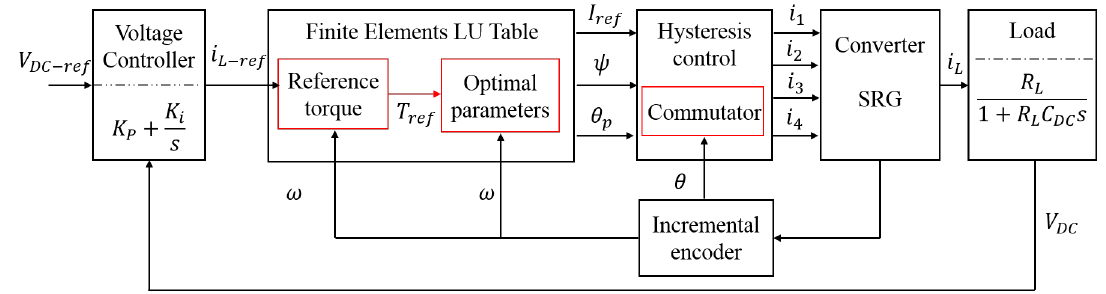
Figure 12. SRG-based drive control block